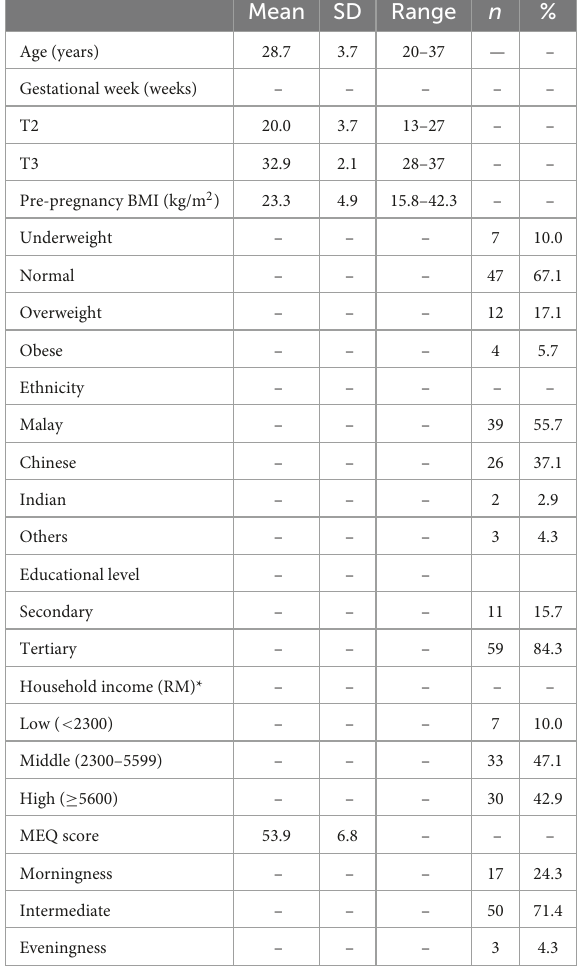
TABLE 1 Characteristics of the study sample ( n =